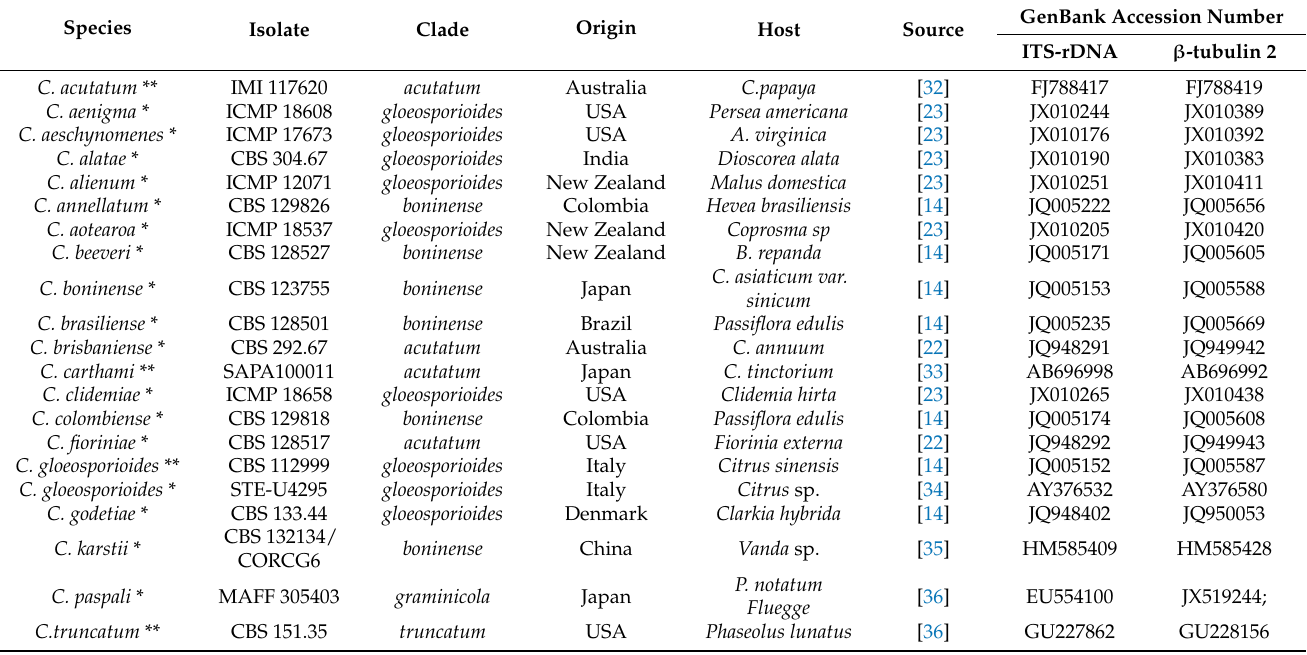
Table 2. GenBank accession numbers of sequences of the isolates of worldwide origin used as references in phylogenetic